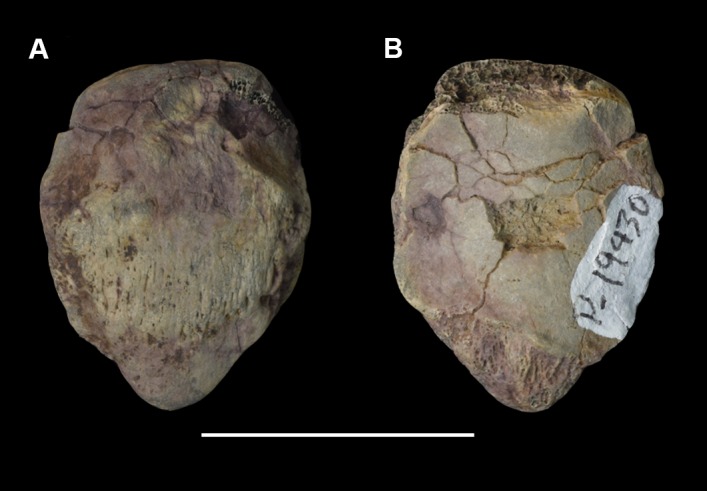
Patella of Periptychus carinidens (NMMNH P-19430).(A) anterior view; (B) posterior view. Scale bar: 30mm.